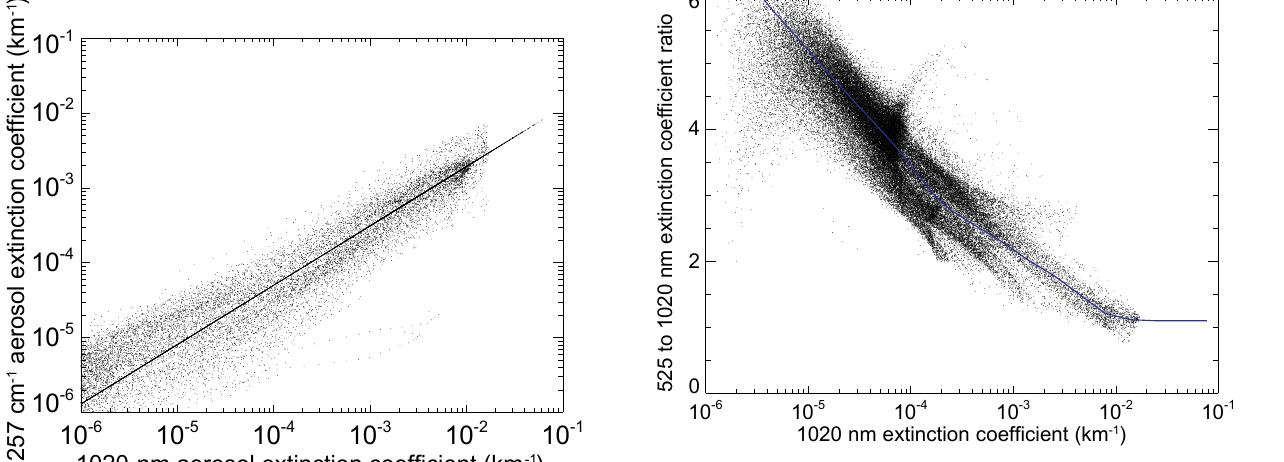
Figure 6. Relationship between the gridded and cloud-cleared CLAES 1257cm − 1 aerosol extinction coefficient versus SAGE II gridded and cloud-cleared 1020nm aerosol extinction coefficient. The solid line shows the conversion relationship used for convert- ing CLAES to SAGE II 1020nm extinction coefficient.